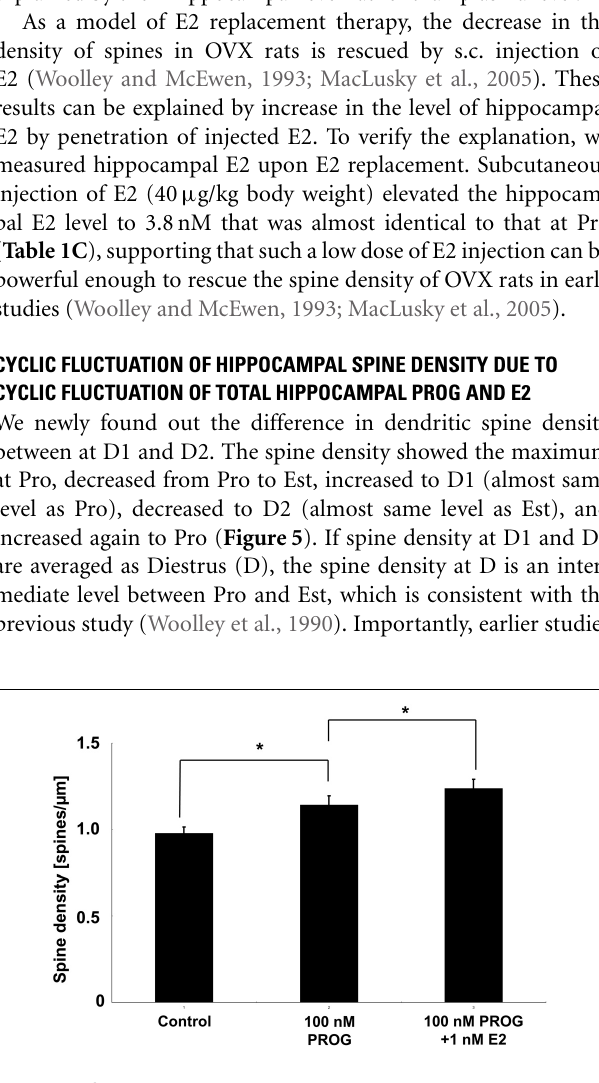
FIGURE 6 | Effect of E2 and PROG on spines of CA1 neurons in acute slices of the hippocampus. Vertical axis is the total number of spines per 1 μ m dendritic segment. Results are represented as means ± sem. ∗ p < 0 . 05. For each drug treatment, we investigated 3 rats, 6 slices, 12 neurons, 24 dendrites, and 1400–2000